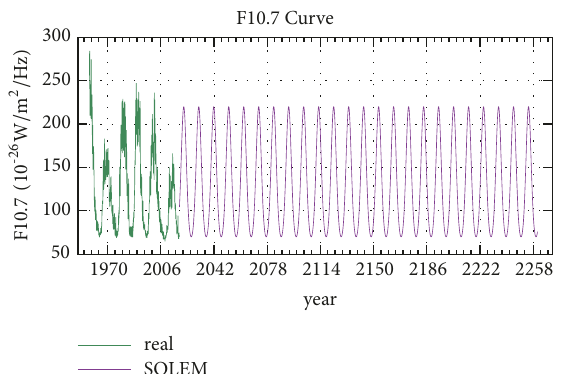
Figure 9: The solar activity recorded in history (green line, denoted as real) and the solar activity model adopted in SOLEM (purple line).